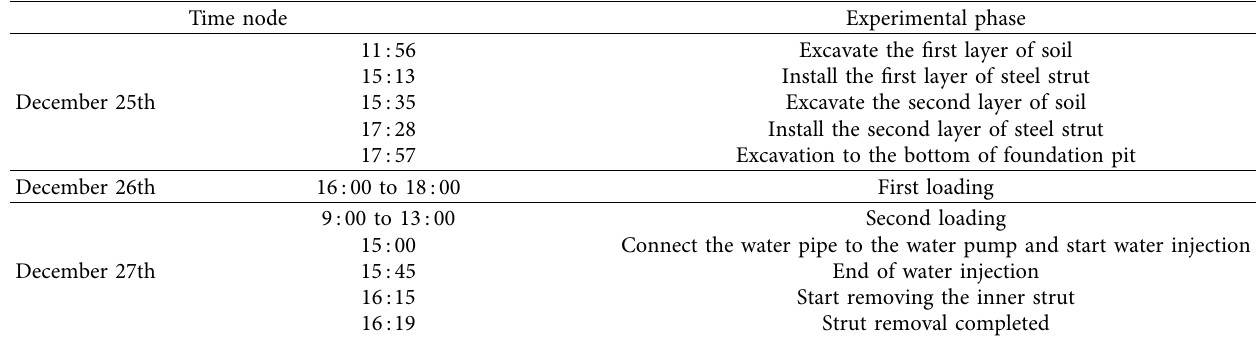
Figure 8: Simulation of test conditions. (a) Pit side loading. (b) Strut falling. Table 1: Statistics of key time nodes in the